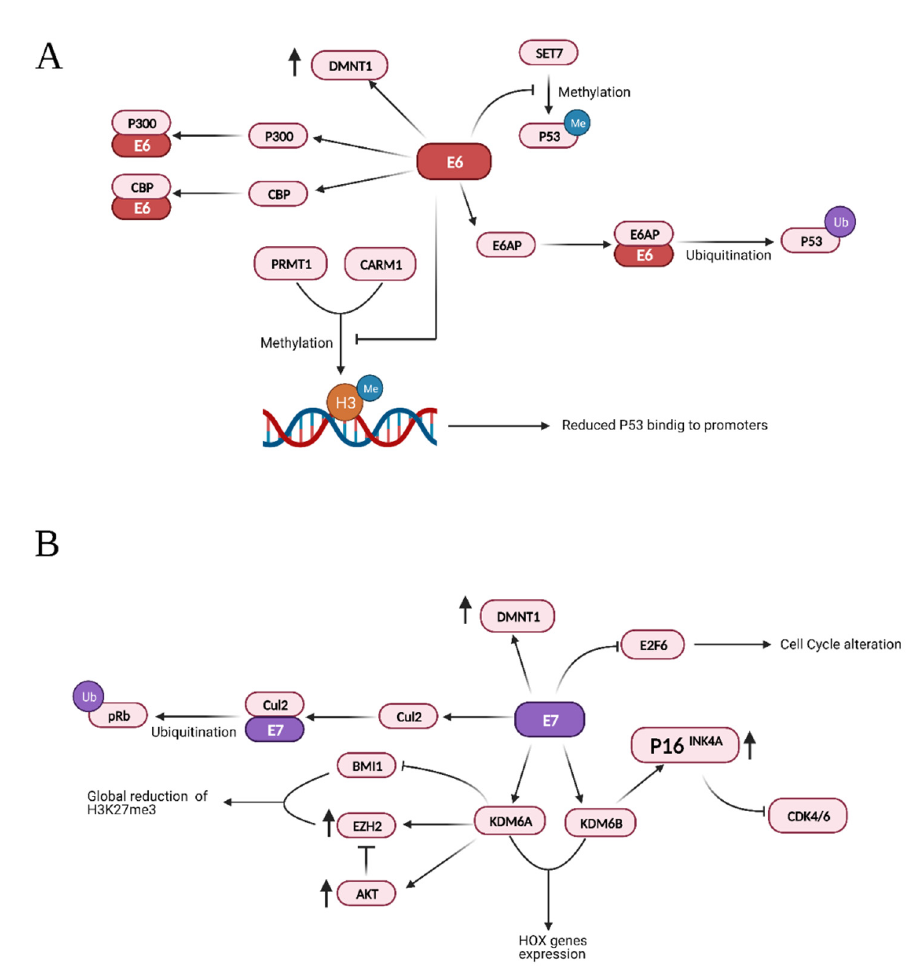
Figure 3. Summary of the effects and interactions of HPV protein E6 ( A ) and E7 ( B ) . Credits: Created with BioRender.com.